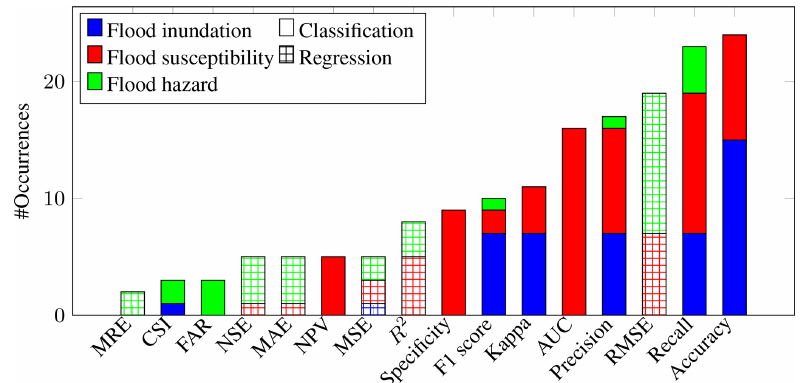
Figure A1. Distribution of the comparison metrics in the reviewed papers per type of application. AUC is the area under the ROC curve, CSI is the critical success index, FAR is the false alarm ratio, MAE is the mean average error, MRE is the mean relative error, MSE is the mean squared error, NPV is the negative predictive value, NSE is the Nash–Sutcliffe efficiency, RMSE is the root mean squared error, and R 2 is the coefficient of determination.